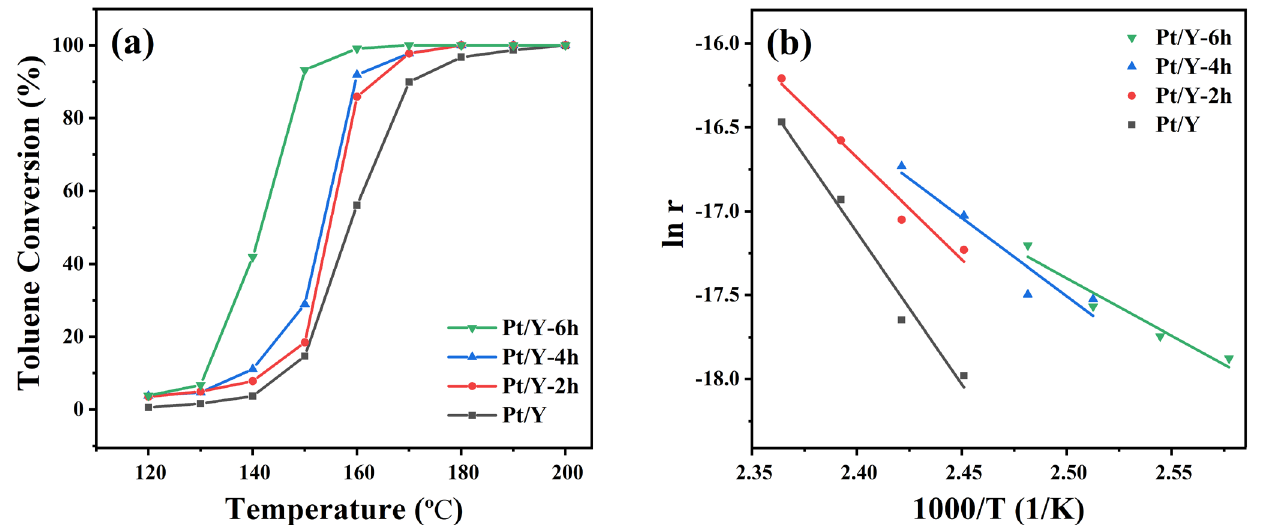
Figure 6. ( a ) Dependence of toluene conversion on temperature in the toluene oxidation reaction using the Pt/Y zeolites (the toluene concentration and gas hourly space velocity were 60,000 mL g − 1 h − 1 , respectively). ( b ) Arrhenius plots of the catalytic oxidation of toluene using the Pt/Y zeolites. The reaction rates were obtained from toluene conversions below 20% in order to eliminate the effects of heat and mass transfer. Table 4. Catalytic performance of the Pt/Y zeolites used in the toluene oxidation reaction. Catalysts